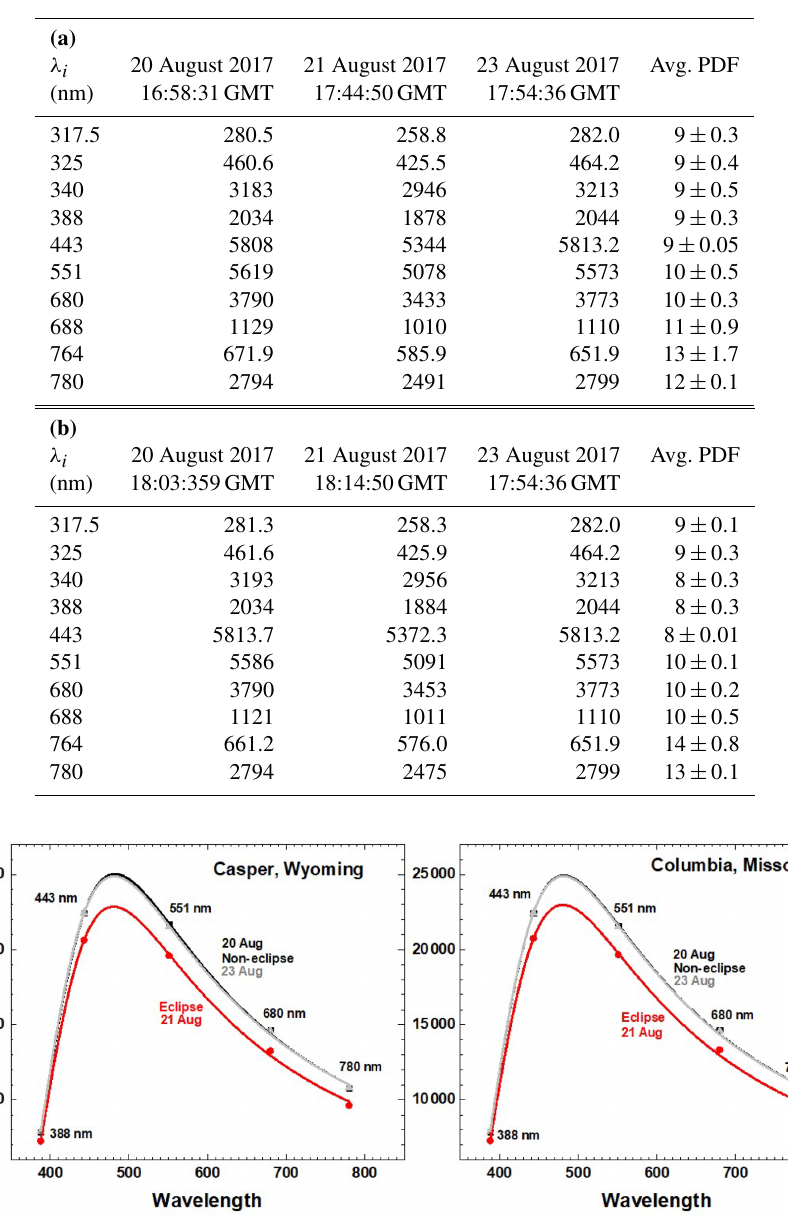
Table 3. (a) Eclipse change in reflected light at Casper, WY, from 20, 21, and 23 August 2017. Units are ICs × 10 − 7 . (b) Eclipse change in reflected light at Columbia, MO, from 20, 21, and 23 August 2017. Units are ICs × 10 − 7 .